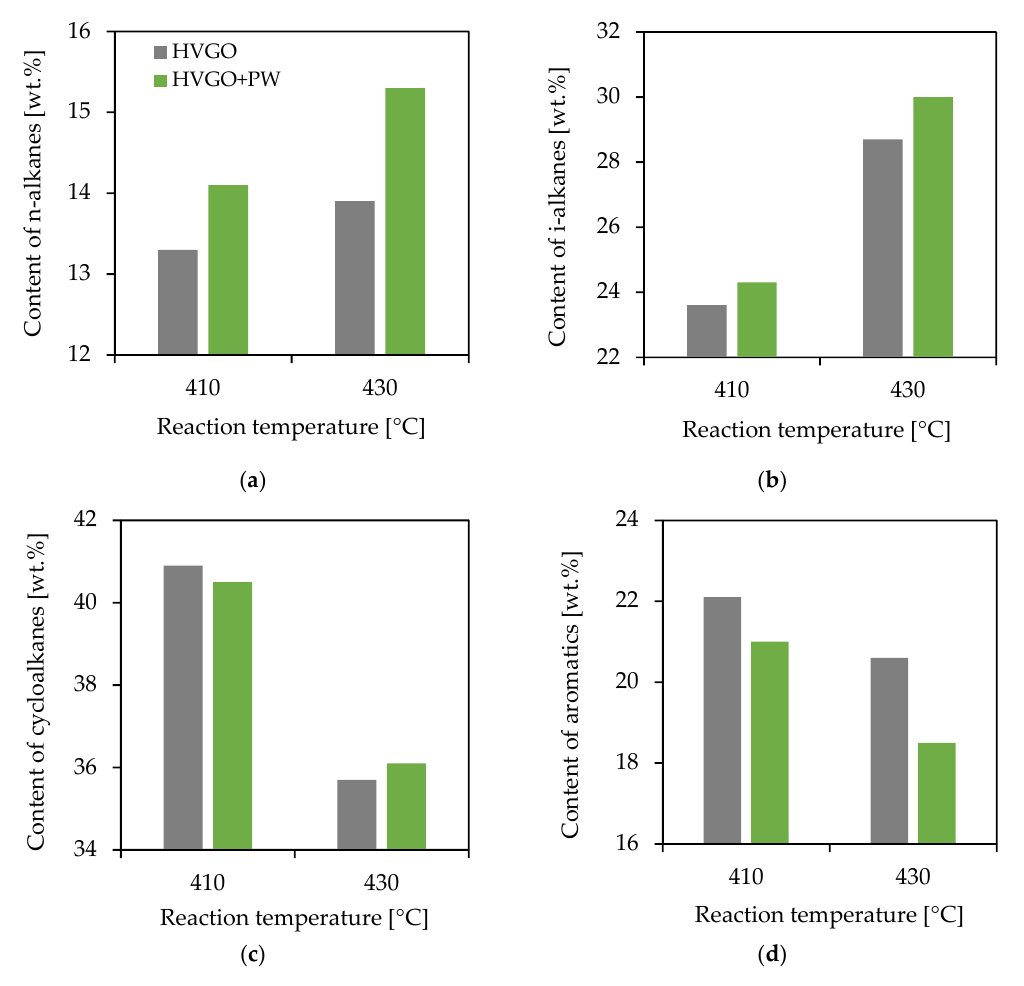
Figure 3. Group-type composition ( n -alkanes ( a ), i-alkanes ( b ), cycloalkanes ( c ), aromatics ( d )) of heavy naphthas obtained by hydrocracking of HVGO and HVGO containing 10 wt.% of petroleum wax (HVGO + PW) at various temperatures. Table 4. Physico-chemical properties of middle distillates obtained by hydrocracking of HVGO and HGVO containing 10 wt.% of petroleum wax (HVGO + PW) at various